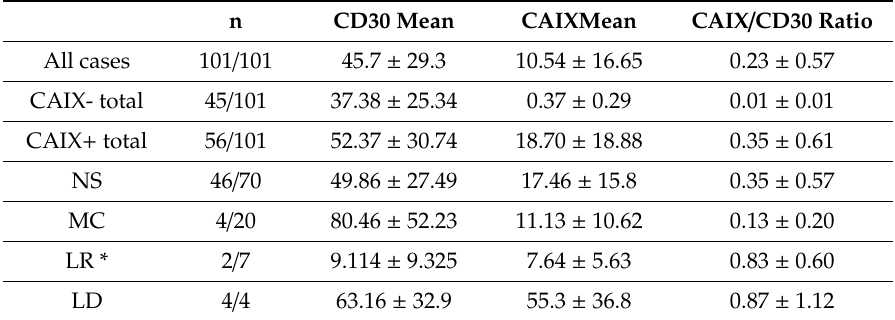
Figure 3. Distribution and mean values of CD30 and CAIX-related H-scores determined by image analysis. The figure demonstrates the individual H-score values determined for the CAIX-negative ( n = 45) and CAIX-positive ( n = 56) groups defined by light microscopy. As negative control CD30- and CAIX-double negative nonclonal lymphoproliferations were measured ( n = 8). The CD30 H-scores representing the total HRS cell burden proved to be higher in CAIX-positive compared to the CAIX-negative samples according to the Mann–Whitney test ( p -value = 0.008, statistically significant). Table 2. H-score based relative CAIX-expression (CAIX/CD30) according to the different histological subtypes of cHL (* only two samples, low cell numbers).